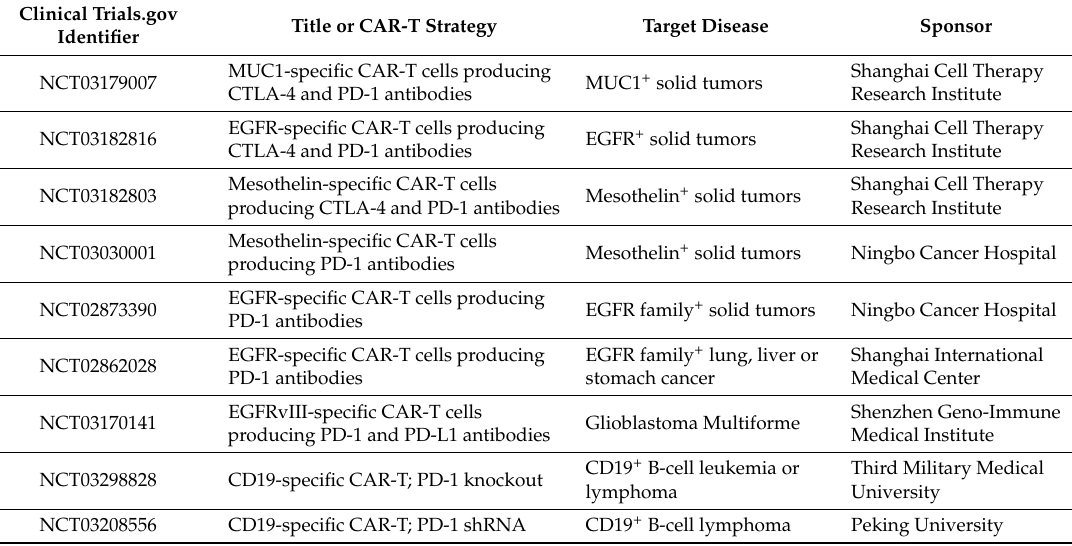
Table 2. Clinical trials involving CAR-T cells harnessing immune checkpoint blockade. Clinical Trials.gov